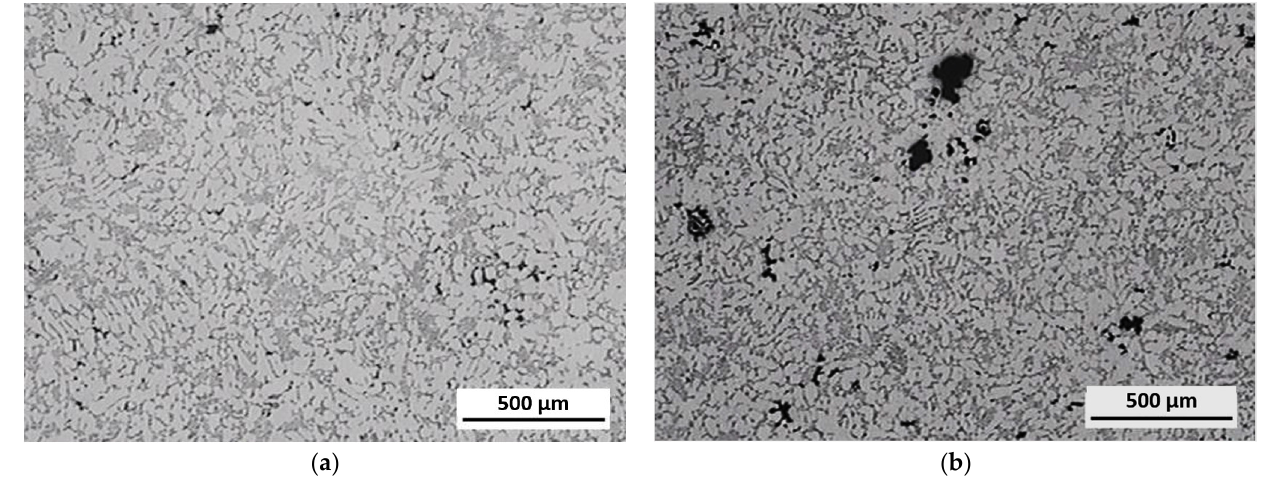
Figure 13. Comparison of the presence of pores in the microstructure of ZnAl4Cu3 alloy: ( a ) after first remelting (C1 alloy) and ( b ) after ninth remelting (C9 alloy).